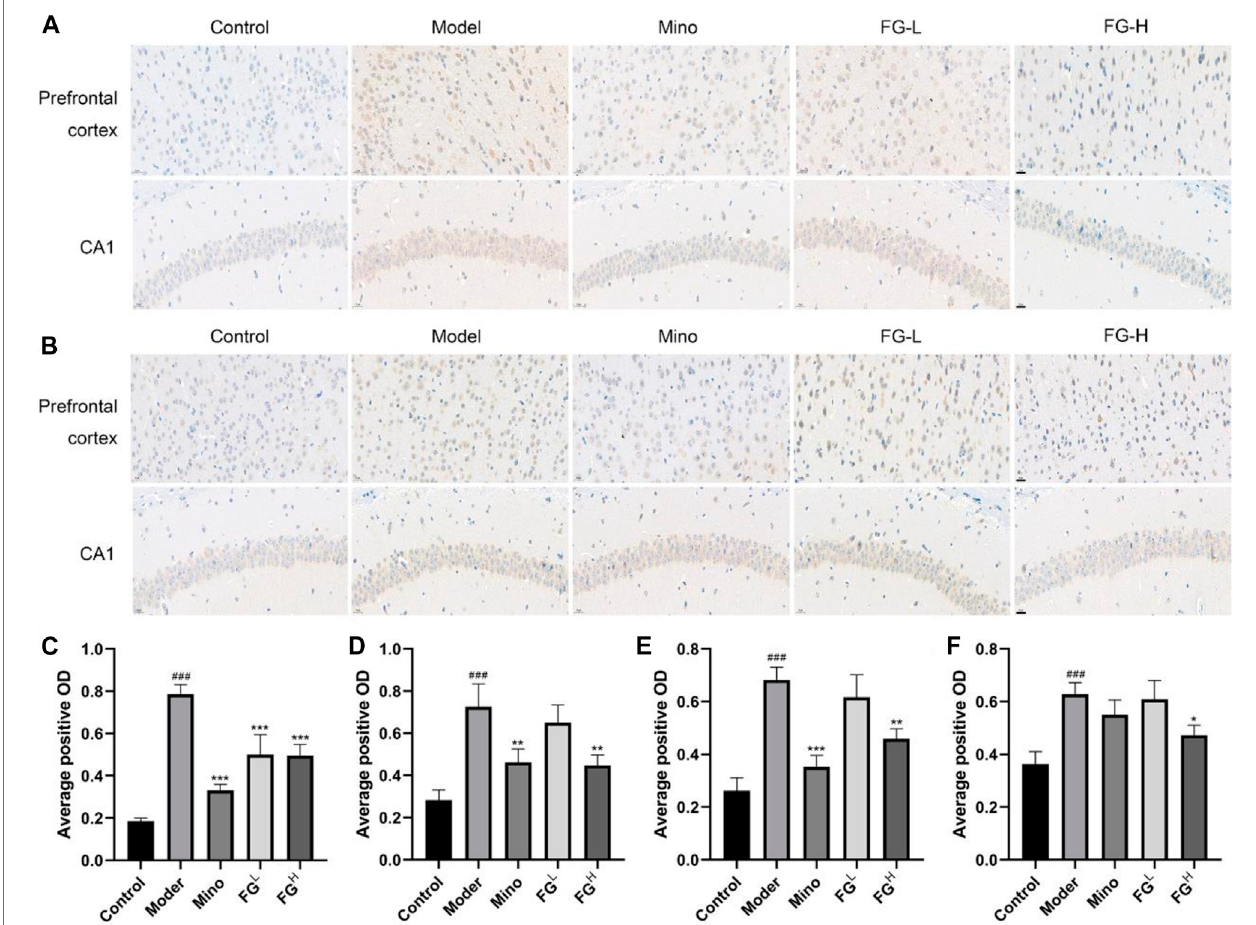
FIGURE11| EffectofFGontheexpressionofiNOSandCOX2intheprefrontalcortexandhippocampalCA1inCRFmodelmice(Scalebar (cid:2) 20 μ m).Afterthelast administrationandbehaviortest,themiceweredeeplyanesthetizedwithanintraperitonealinjectionofsodiumpentobarbital(45 mg/kg)andtranscardiallyperfusedwith normalsalinefollowedby4%paraformaldehydesolution.TheexpressionsofiNOS (A,C,D) andCOX2 (B,E,F) intheprefrontalcortexandhippocampusCA1regionof the mice were detected by immunohistochemistry. Results are expressed as mean ± SD ( ### p < 0.001 compared with control group; * p < 0.05, ** p < 0.01, *** p < 0.001 compared with model